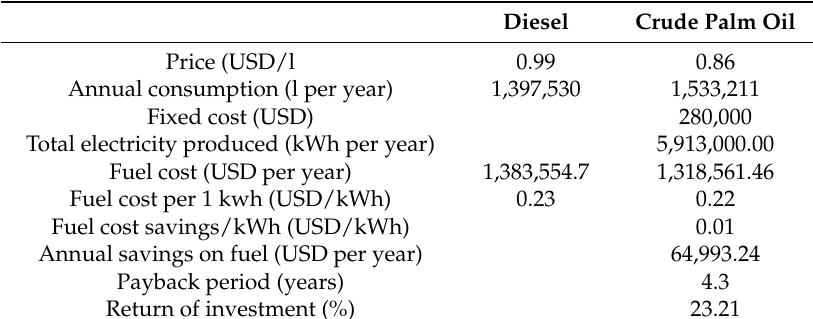
Table 3. Economy of a CPO power plant in